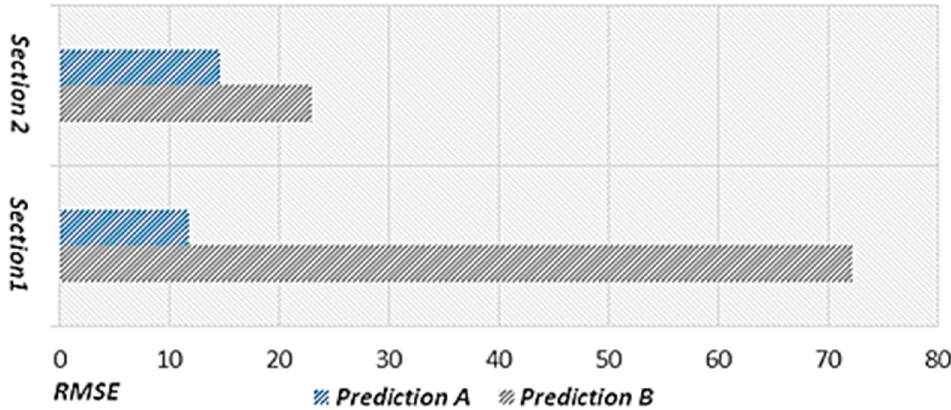
Figure 19. RMSE value considering the event weight. (Section 1) the section in which the speed change occurred in the morning. (Section 2) the section in which the speed change occurred in the afternoon.